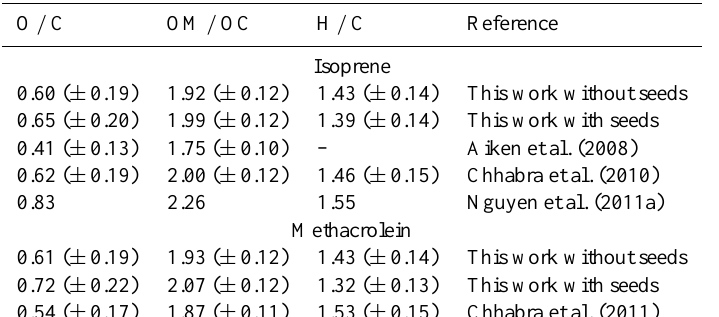
Table 3. Average elemental ratios of SOA from isoprene and MACR photooxidation. Values in parentheses reflect the measurement uncer- tainty as determined by Aiken et al. (2008).